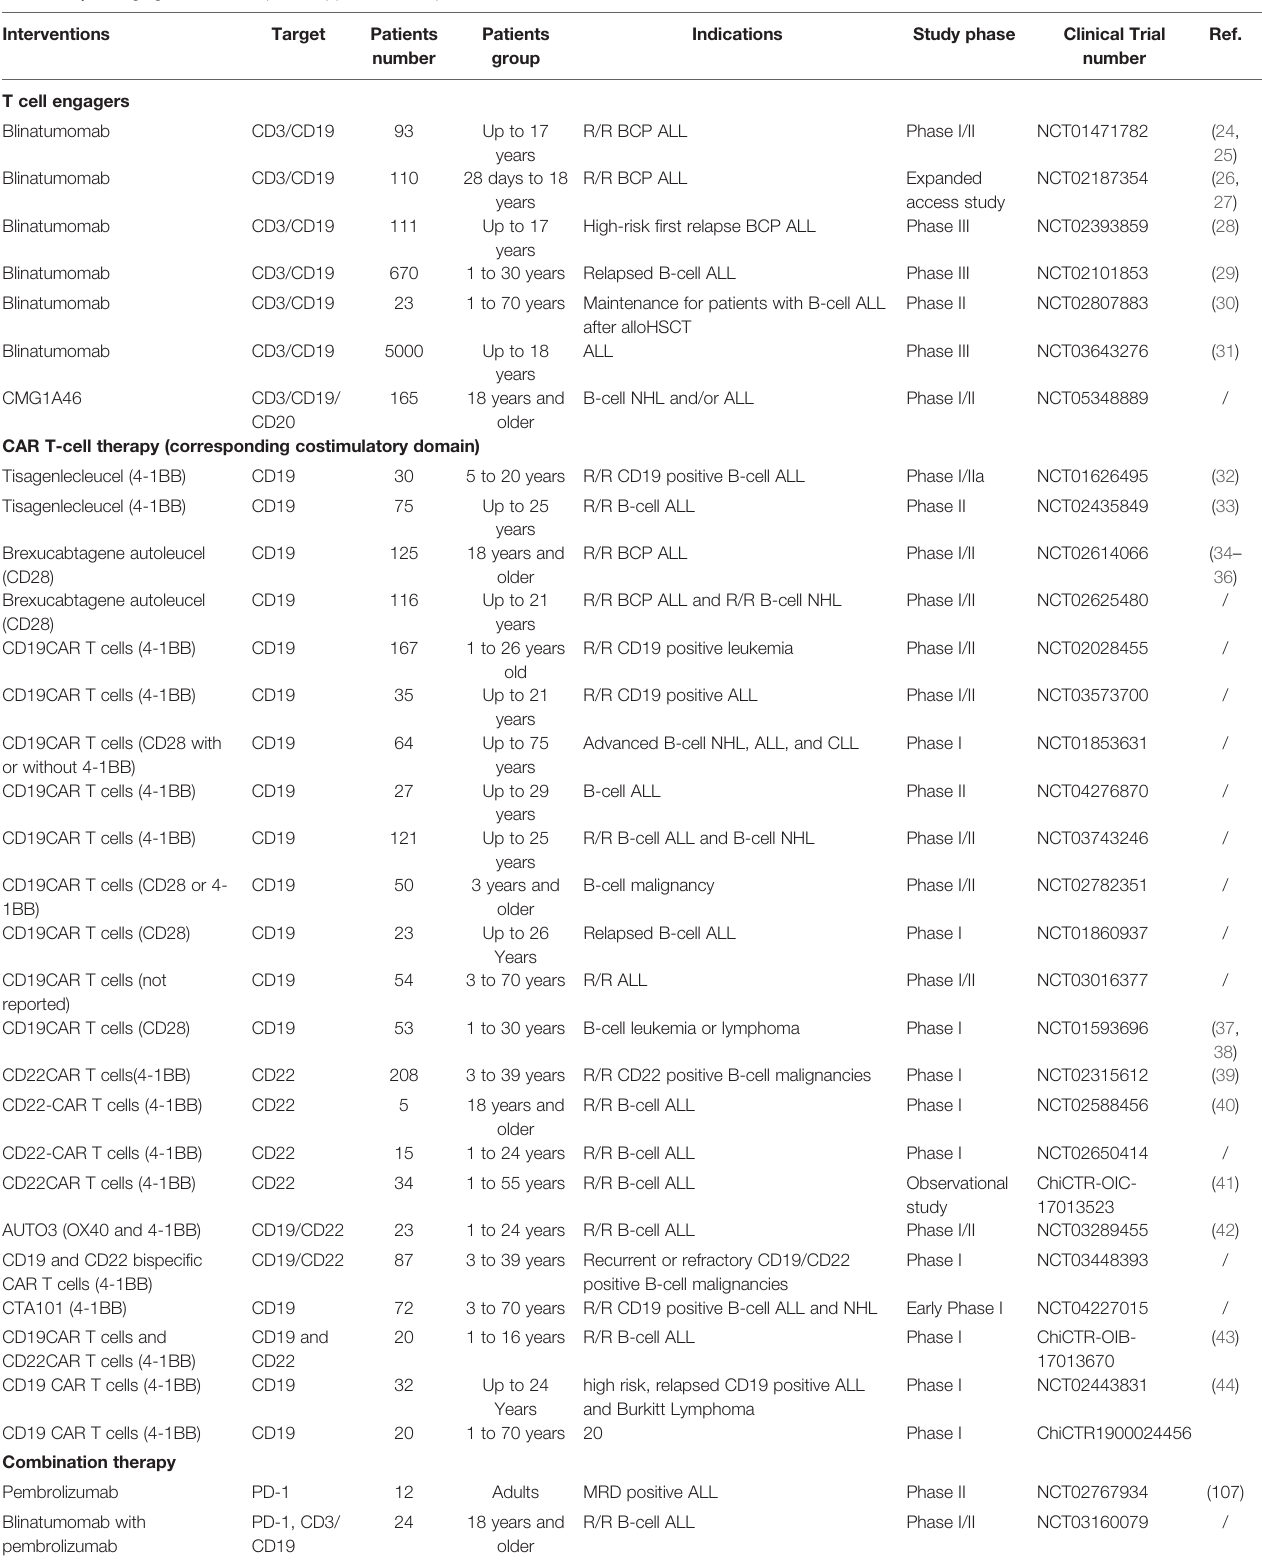
TABLE 1 | Emerging immunotherapeutic approaches for pediatric B-cell